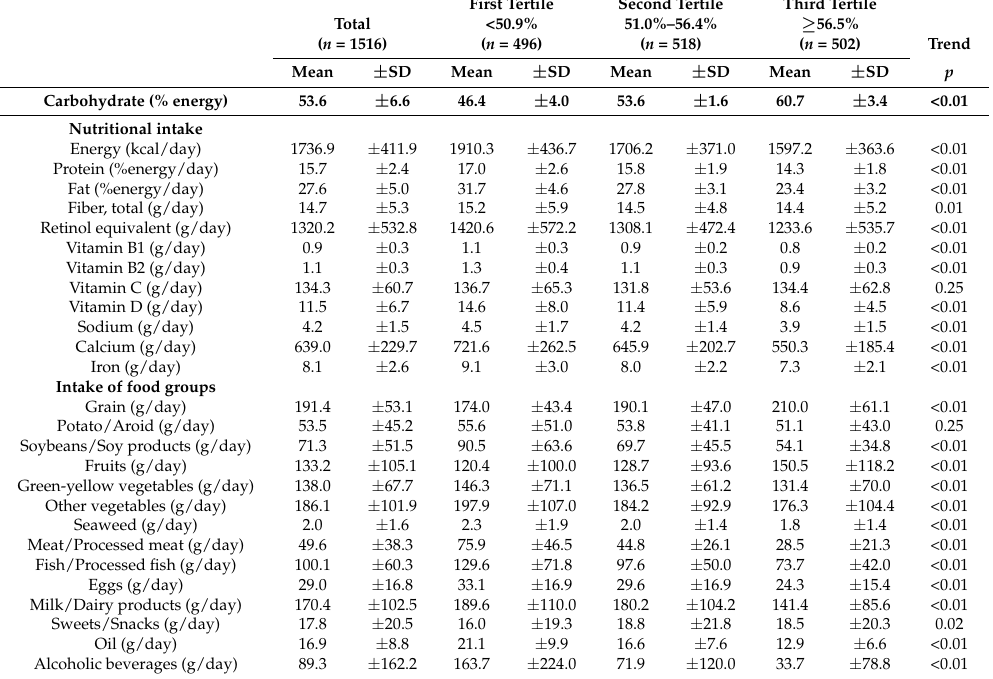
Table 2. Food groups and nutritional intake per day by the 1516 patients with type 2 diabetes according to proportion of carbohydrate intake at